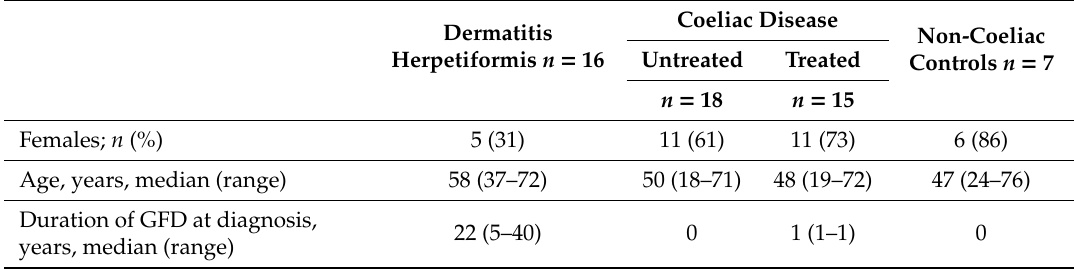
Table 1. Demographic data of patients participating the